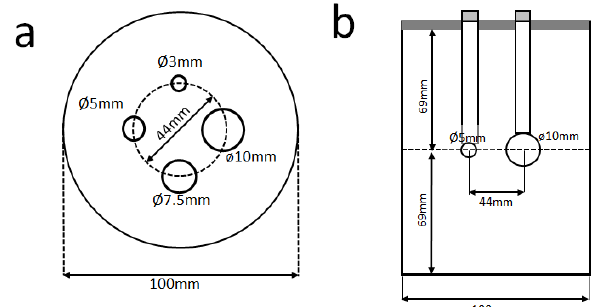
Figure 2. Cross-sections of the phantom with dimensions. Transverse plane view ( a ) and lateral view ( b ) of the breast phantom in which the spheres were arranged. Note: The order of the 7.5 mm diameter and 5 mm diameter spheres is rotated between the two scanners due to an error in the phantom setup.